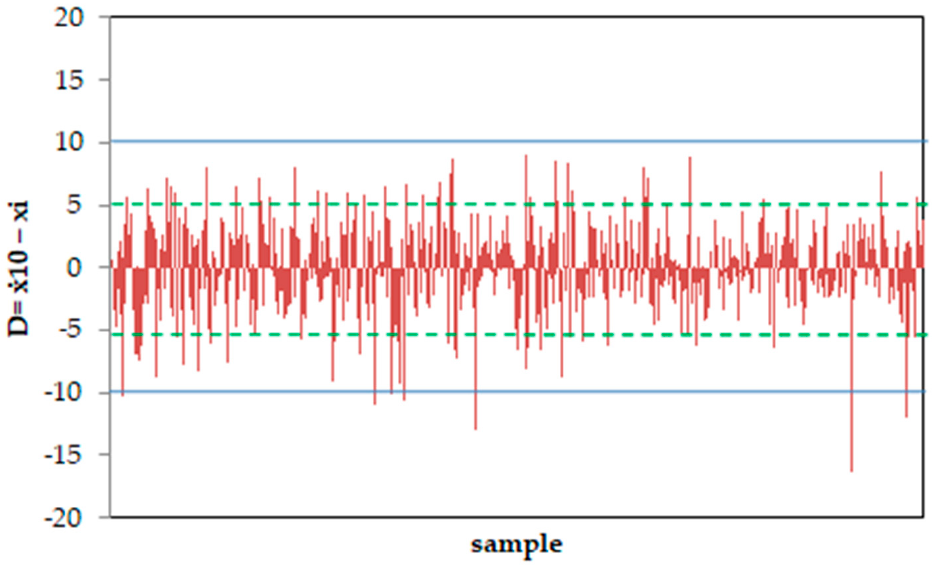
Figure 9. Fineness uniformity: European (±10%) and ASTM C 618 (±5%) requirements for the residues on the 45 µm sieve, calculated from 765 spot samples picked in a period of ten years.